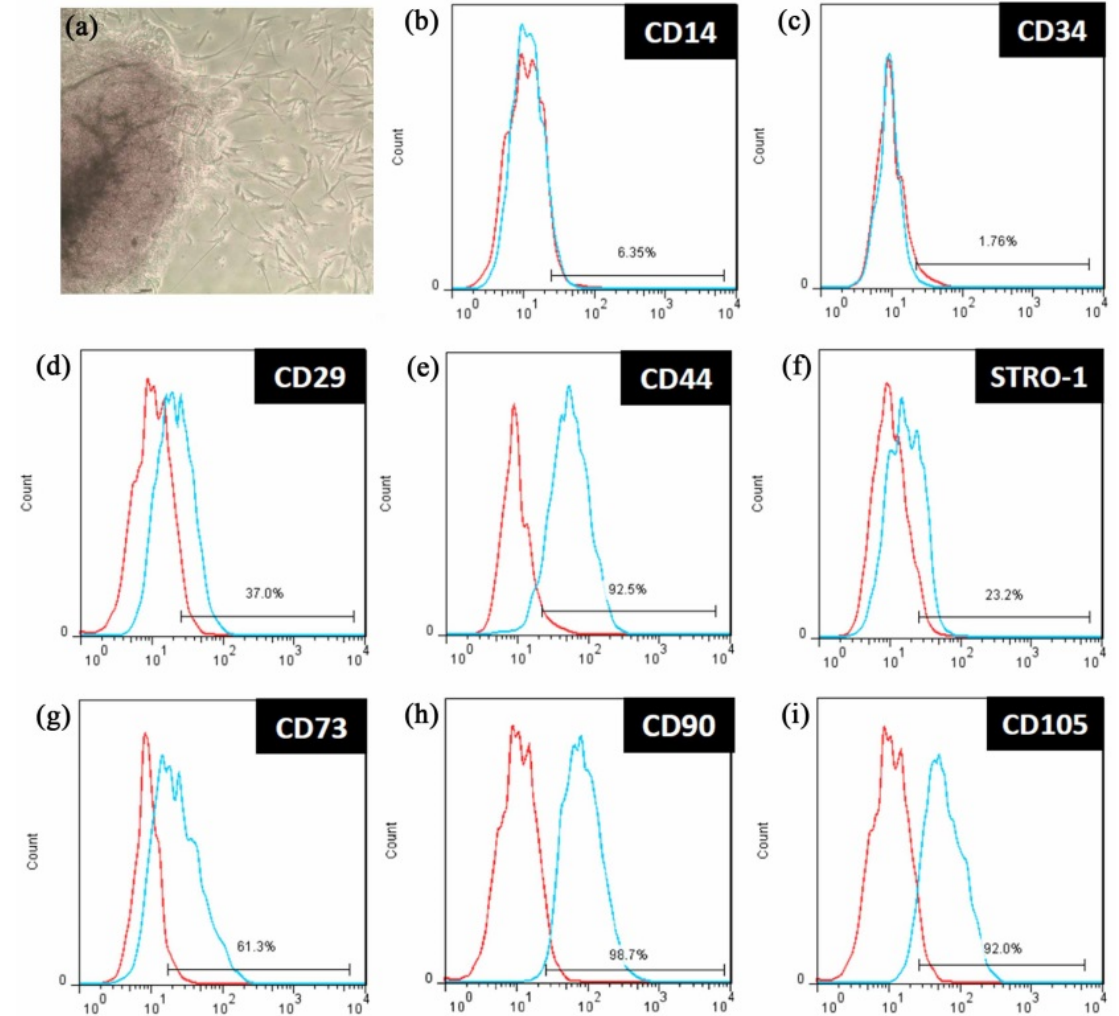
Figure 2. Characteristics of isolated dental pulp stem cells ( a ) used in this study were confirmed by negative expression of ( b ) CD14 and ( c ) CD34 but positive expression of ( d ) CD29, ( e ) CD44, ( f ) STRO-1, ( g ) CD73, ( h ) CD90, and ( i ) CD105. Blue and red lines represent the positive-stained and control cells, respectively.